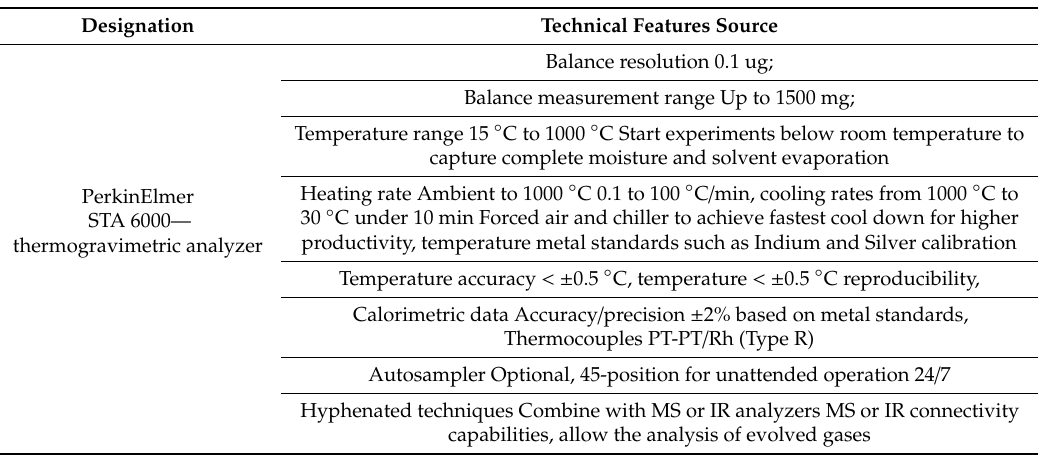
Table 3. PerkinElmer STA 6000 Technical Characteristics—Thermogravimetric Analyzer − (Source: PerkinElmerhttps).